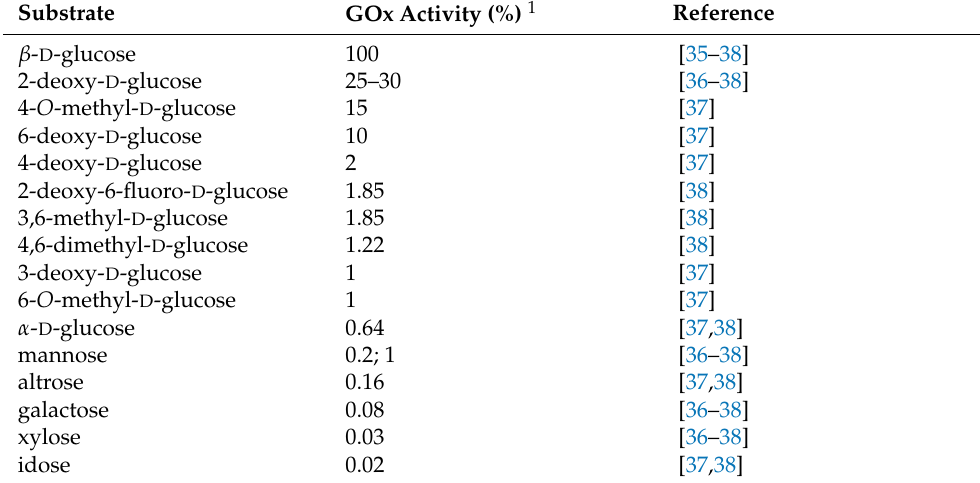
Table 3. Some glucose oxidase